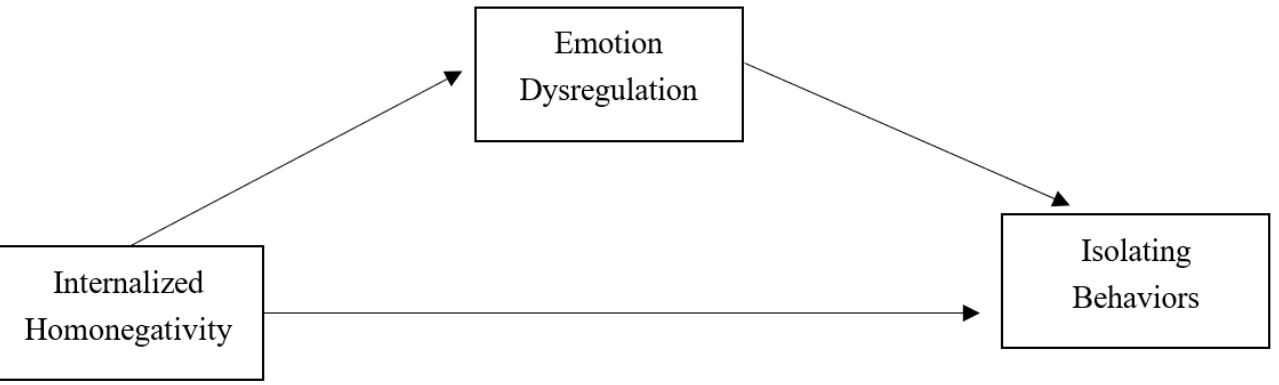
Figure 1. Hypothesized model. Note: mediation model with emotion dysregulation as mediator and sex, sexual orientation, education level, and economic condition as controlling variables.